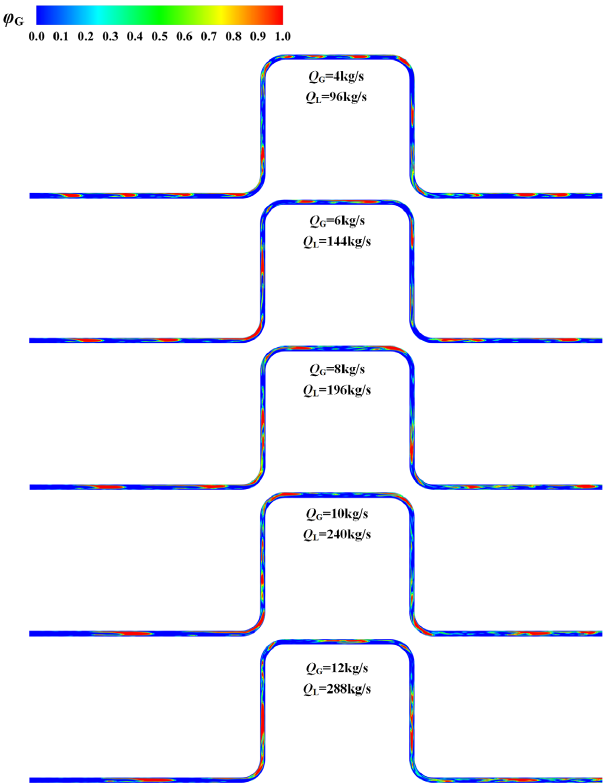
Figure 17. Comparison of the flow regimes (instantaneous snapshots after the flow reaches periodic stability) in the jumper at different inlet mass flow rates.